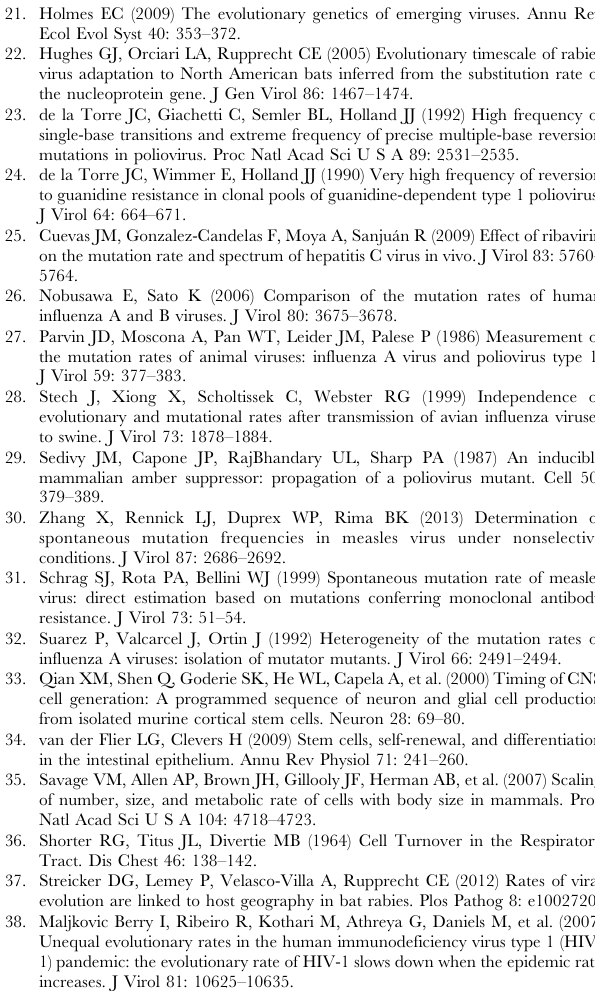
Table S7 Non-structural gene substitution rate varia- tion among viruses with different cell tropisms. Based on the control datasets with one substitution rate per viral species. The significance of viruses with each target cell in the left column having higher log scale mean substitution rates than the viruses with each target cell in the top row is designated with a p-value from a one-tailed t-test. The threshold for statistical significance ( P , 0.01) was Bonferroni-corrected to account for multiple